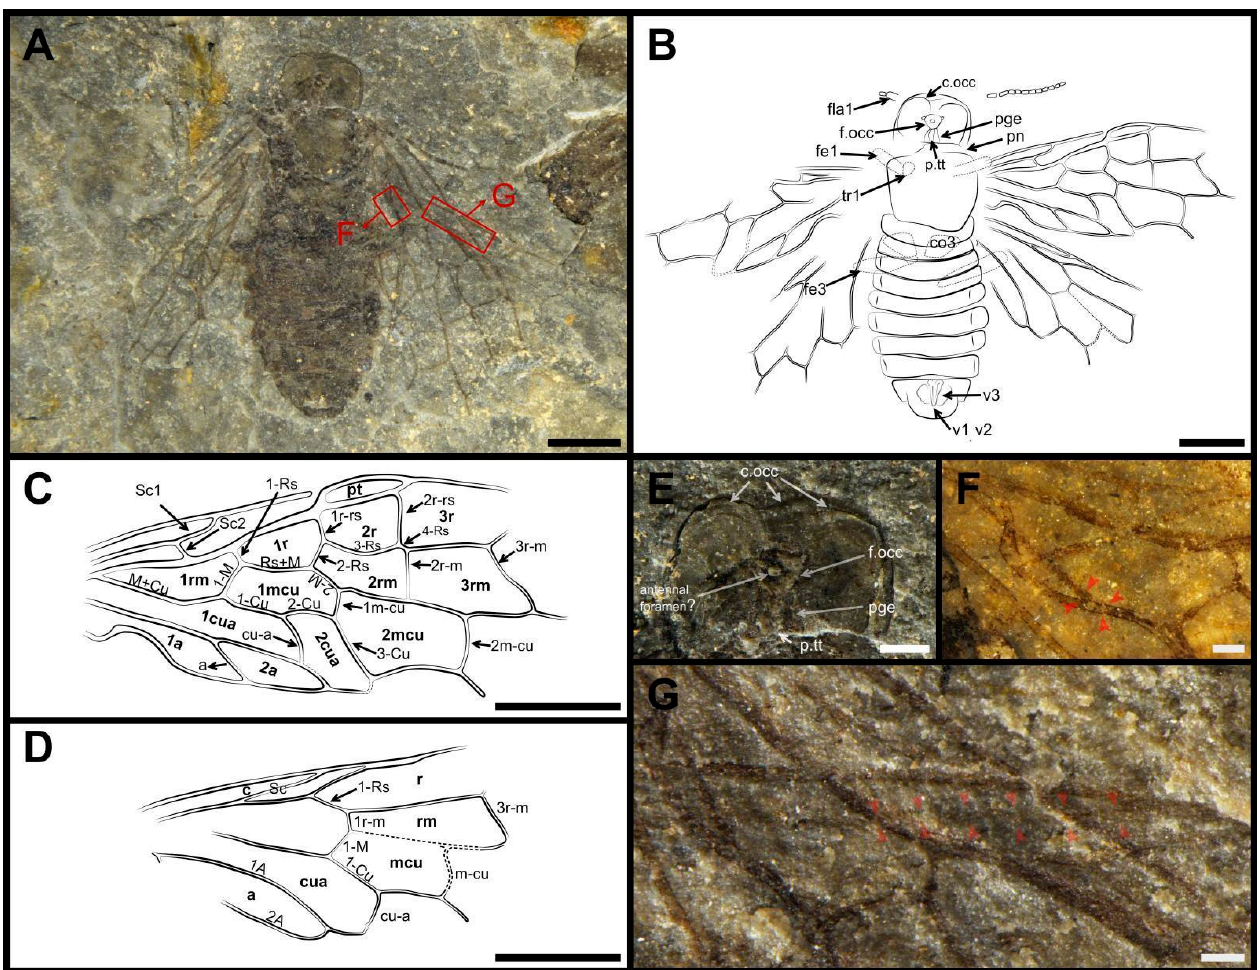
Figure 5. Dolicholyda angusta sp. nov., Holotype, (CNU-HYM-ND2022108), female. ( A ), dorsal view. ( B ), line drawing of dorsal view with forewing and hind wing artificially rotated from body and each other for better viewing. ( C ), line drawing of forewing after reconstruction (mirror flip for the anal field). ( D ), line drawing of hind wing. ( E ), head under alcohol. ( F ), vein M+Cu in forewing under alcohol. ( G ), Sc in hind wing. Symbols: fe1, fe3 = fore and hind femur; tr1 = fore trochanter; v3 = 3rd valvifer; co3 = hind coxa; c.occ = occipital carina; f.occ = occipital foramen; pge = postgena; p.tt = tentorial bridge. Cell names are in bold. Arrows in red mean the venations here are highlighted. Scale bars: 2 mm in ( A – D ); 0.5mm in ( E ); 0.25 mm in ( F , G